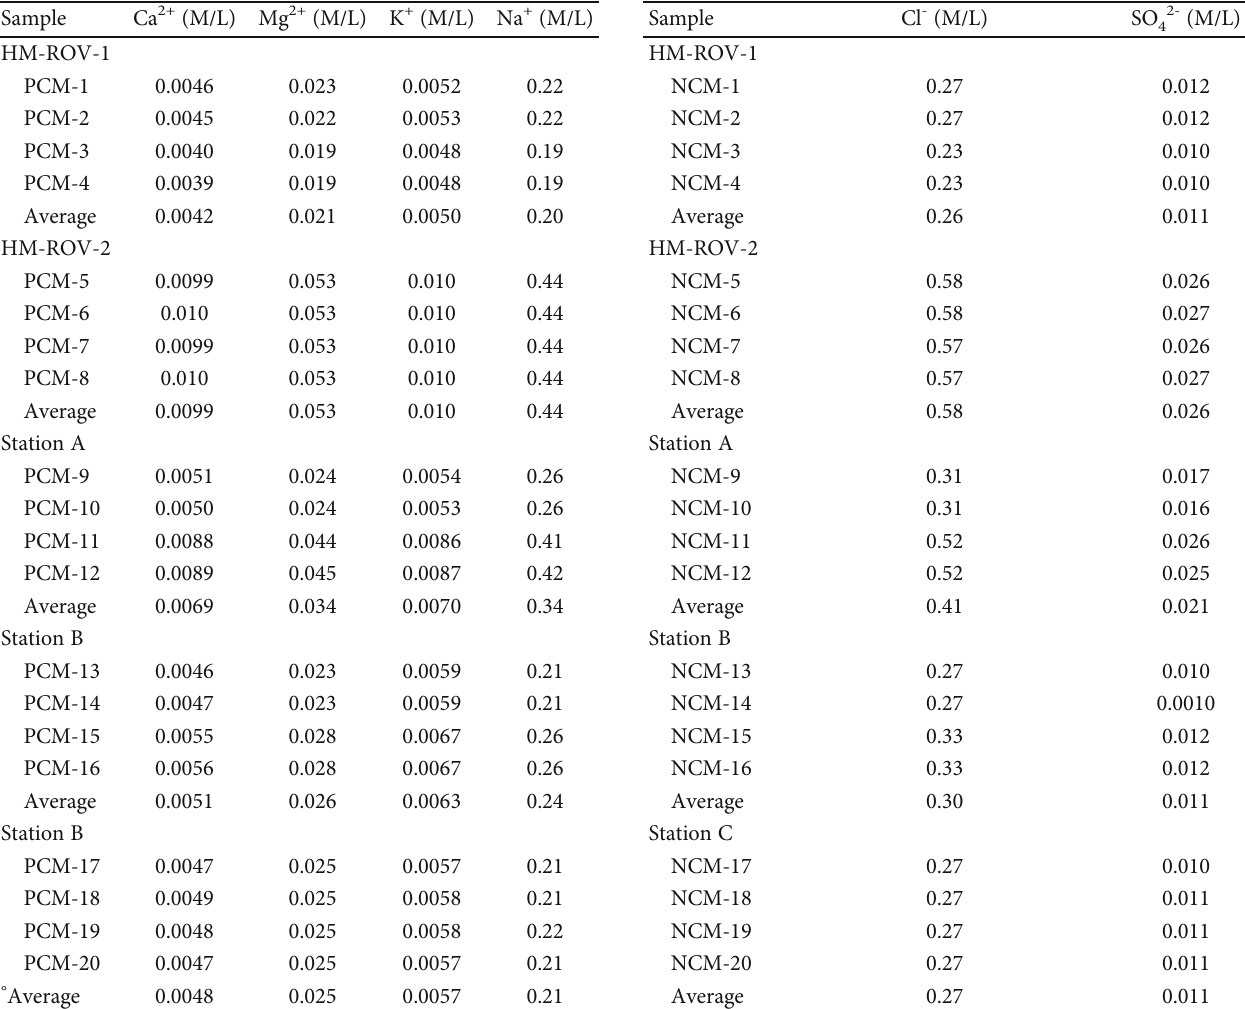
Table 3: Main cation concentrations of samples recovered from di ff erent cold seeps.